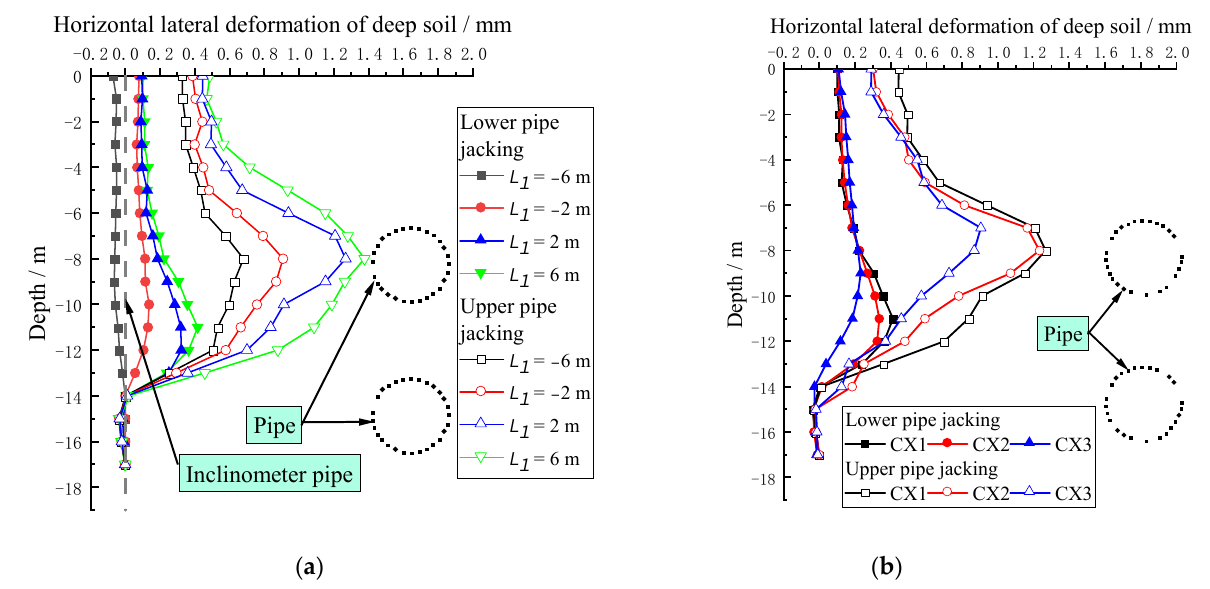
Figure 6. Horizontal lateral deformation curve. ( a ) Horizontal lateral deformation curve of CX1 at different construction stages; ( b ) horizontal lateral deformation curves of CX1, CX2 and CX3 at L 1 = 6 m.